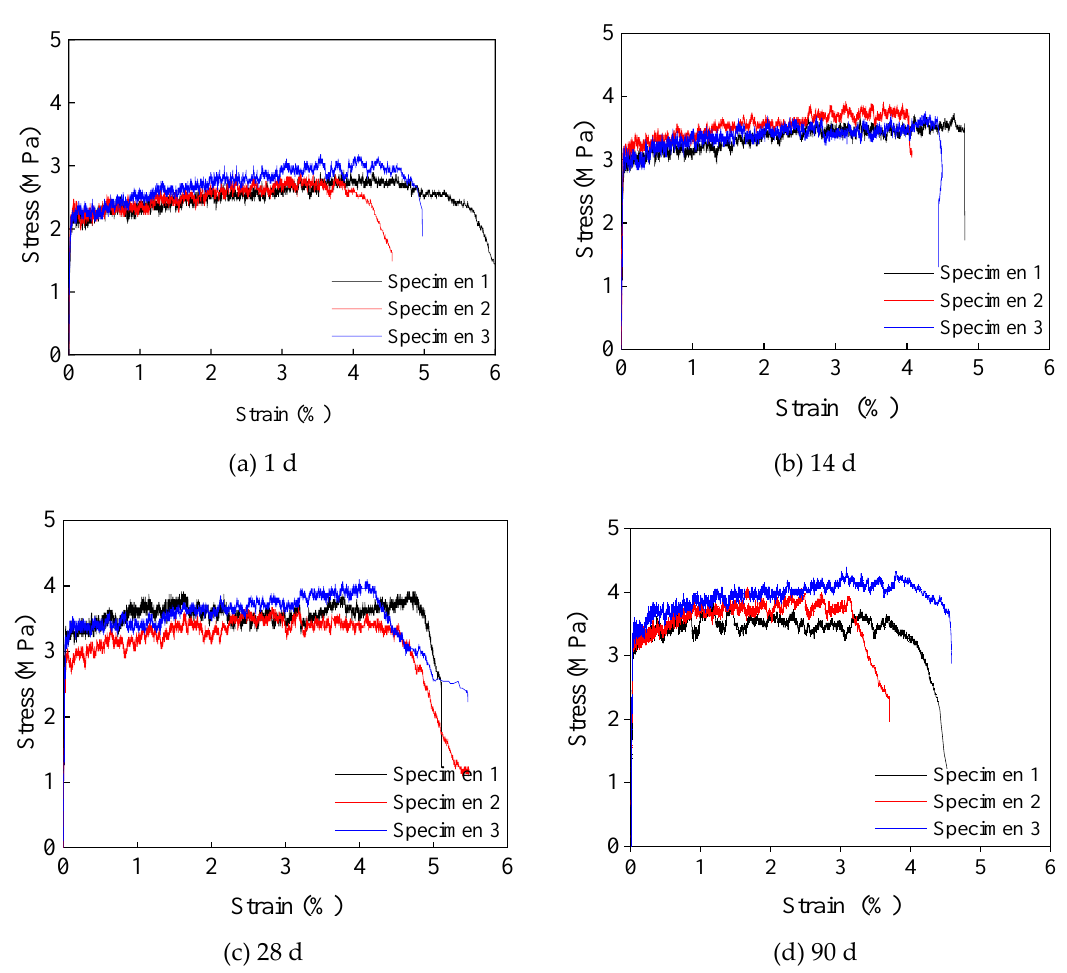
Figure 7. Stress–strain curves of SHCC at different curing ages